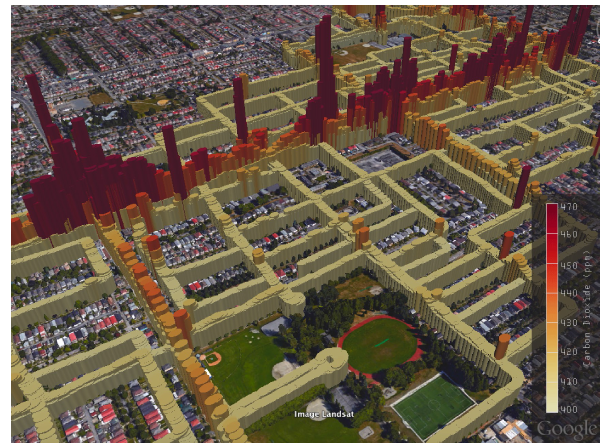
Figure 4. Three-dimensional visualization of all raw r mobile measurements from all systems (summer campaign) in the “Sunset/Victoria-Fraserview” neighbourhood. The visualization is illustrating the high density of measurements taken along streets, laneways, and in parks. The linear area with many higher mixing ratios is the busy six-lane “Knight St.” with ≈ 50000 vehicles per day. Image visualized in Google